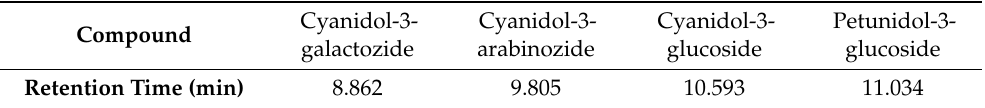
Table 2. Anthocyanins used as standards in HPLC analysis and their retention